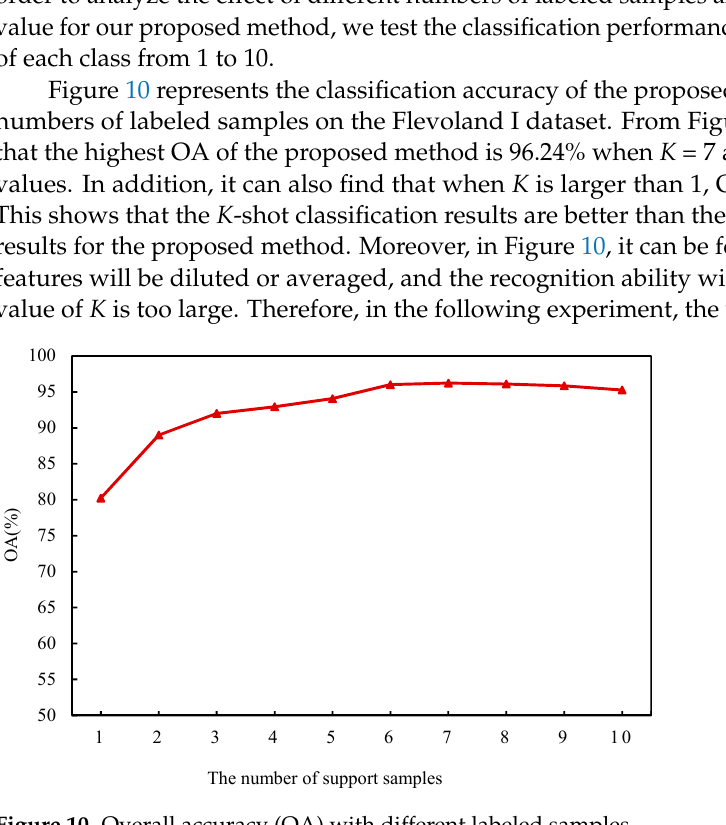
Figure 10. Overall accuracy (OA) with different labeled samples.